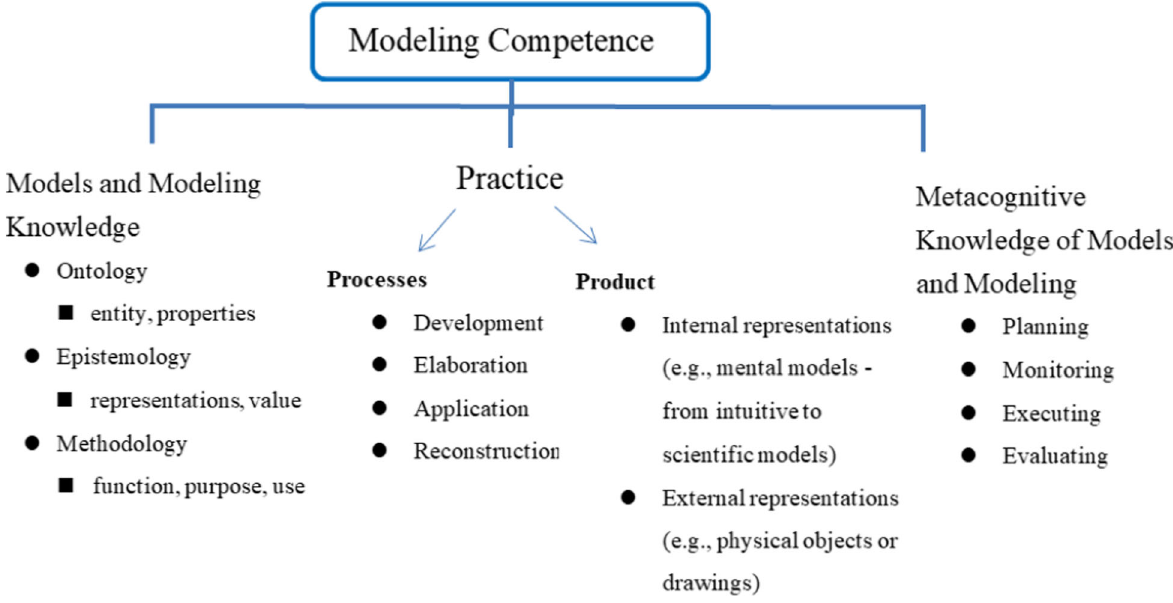
Fig. 1 The components of modeling